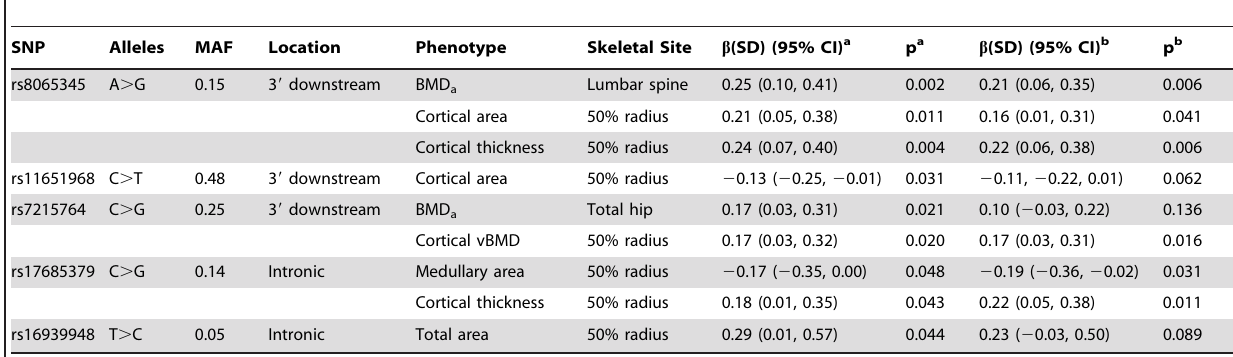
Table 5. MAP3K14 SNP associations with bone mineral density and radius geometric